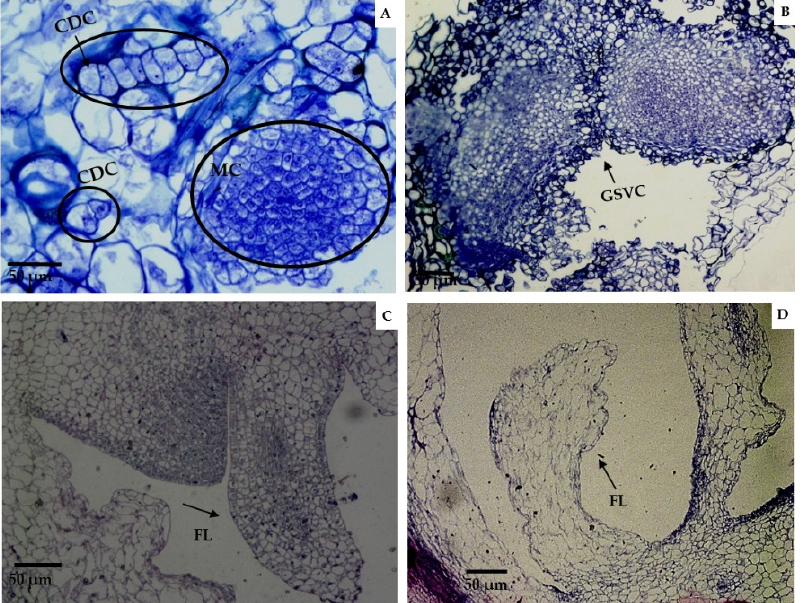
Figure 5. Histological samples that show the intense meristematic activity that occurred in the regeneration with the M7 treatment. ( A ) Meristematic cells (MC) in active cell division (CDC), vacuolated, isodiametric cells, and prominent nucleus are observed, as well as the successive divisions of the cells to give rise to the formation of the somatic embryo; ( B ) Globular embryos advanced in their development without vascular connection (GSVC) with the maternal tissue and where the suspensor rupture is appreciated; ( C , D ) Formation of the first leaf primordia (FL).